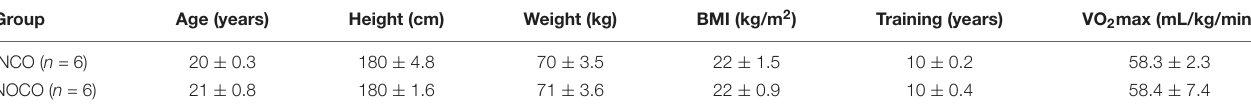
TABLE 1 | Anthropometric data and pre-training VO 2 max.